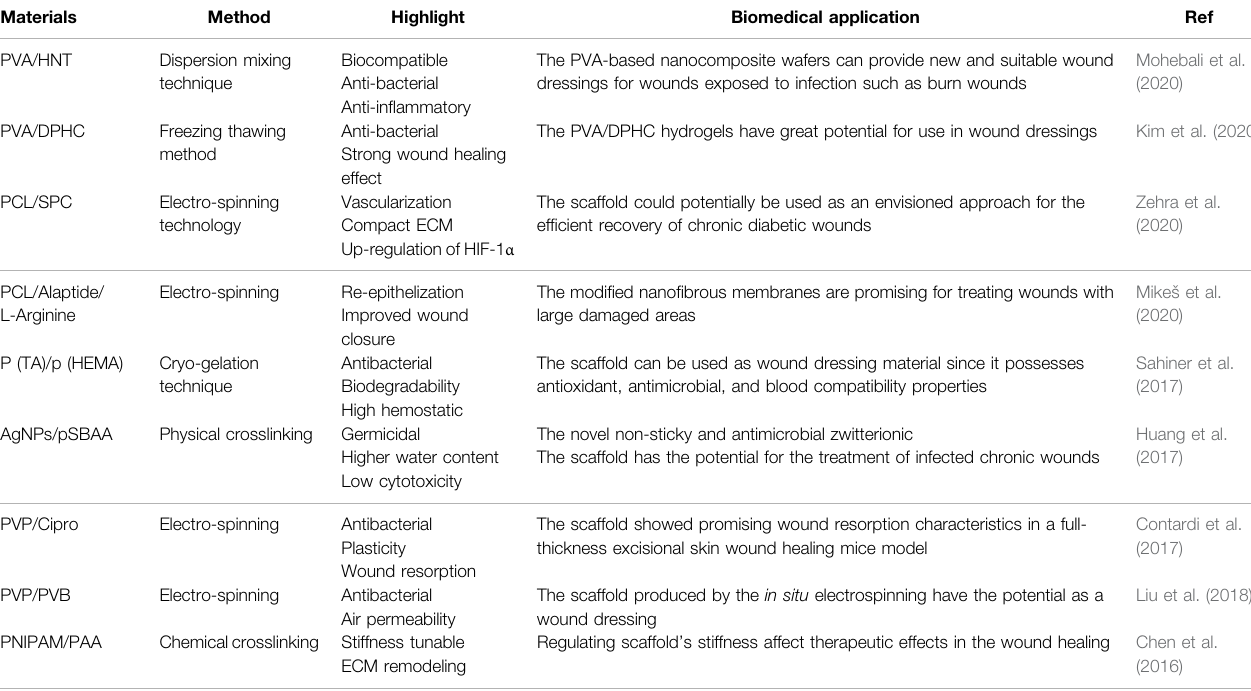
TABLE 2 | Synthetic materials of bioengineered scaffolds.